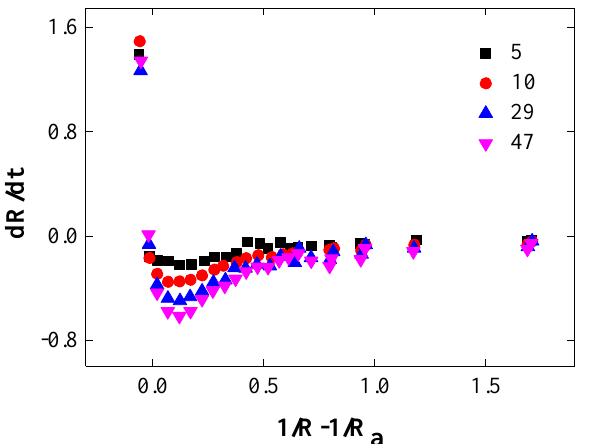
Figure 12. Kinetics of individual grains during AGG. The number of original datapoints are more